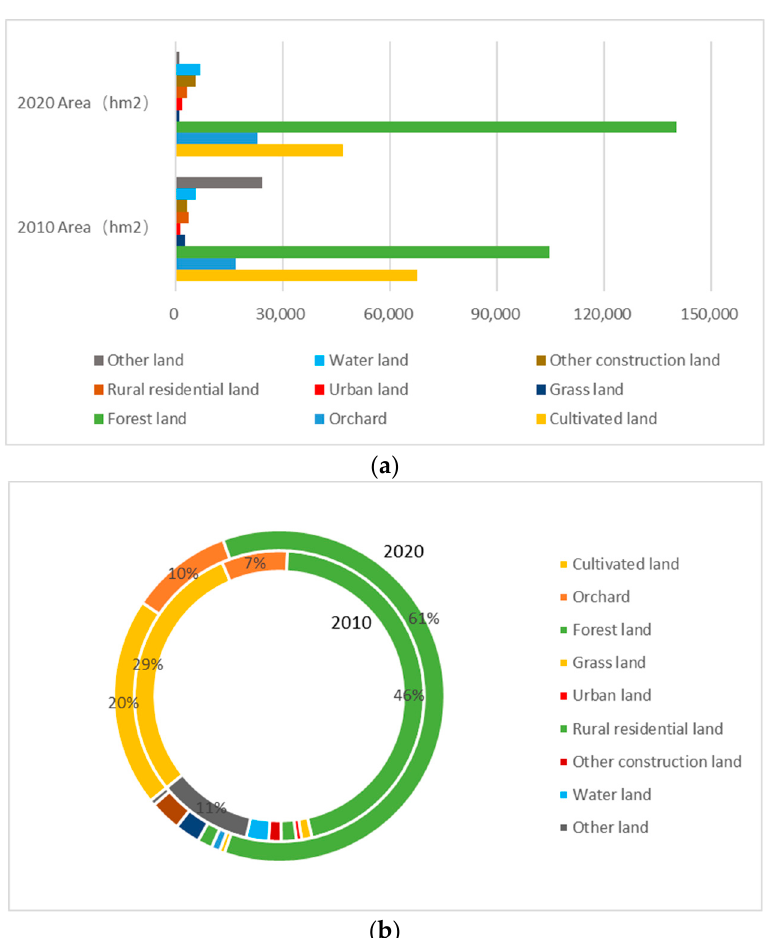
Figure 3. ( a ) Comparison of the number of land-use types from 2010 to 2020; ( b ) Comparison of the structure of land-use types from 2010 to 2020.